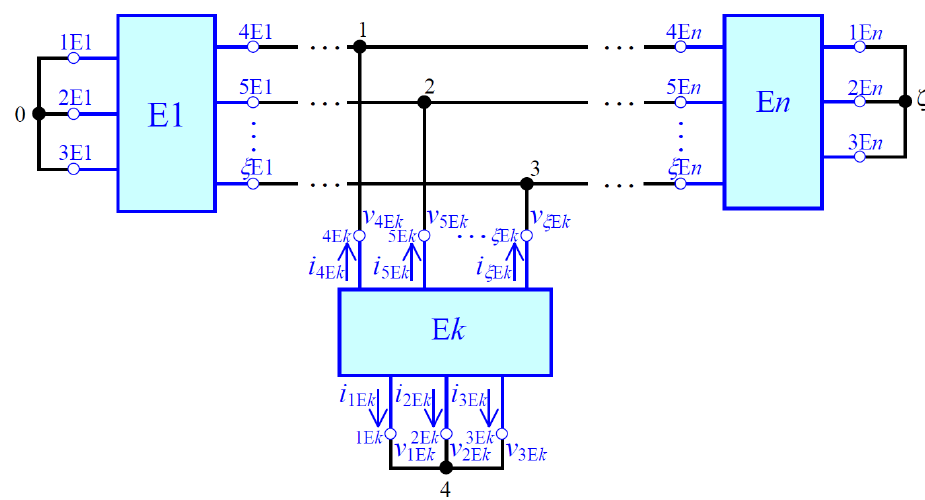
Figure 2. Schematic diagram of the example of an electric system as the connection of multipoles.